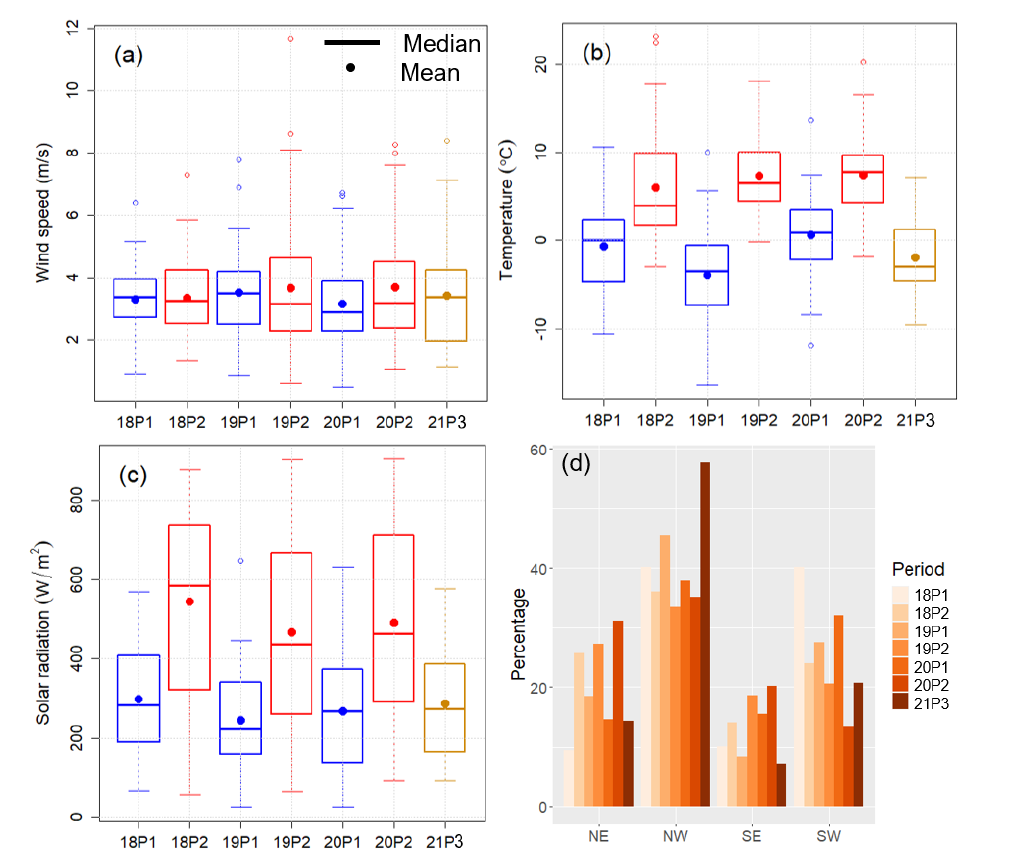
Figure 5. Box and whisker plots of daily afternoon (12:00 to 16:00 local time) ( a ) wind speed; ( b ) temperature; and ( c ) solar radiation measured from the roof of the MP building during the examined periods: “18P1” for 2018 Period 1, “18P2” for 2018 Period 2, etc. The description of the box and whisker plots is the same as for Figure 3. ( d ) Frequency of wind within each wind direction sector in the afternoon (12:00 to 16:00 local time) measured from the roof of the MP building. The bar represents a period as noted by